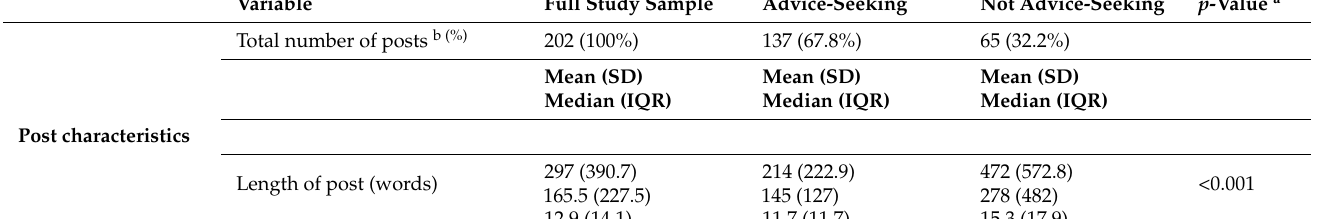
Table 1. Description of data with respect to post characteristics, network characteristics, and bu- prenorphine use status.